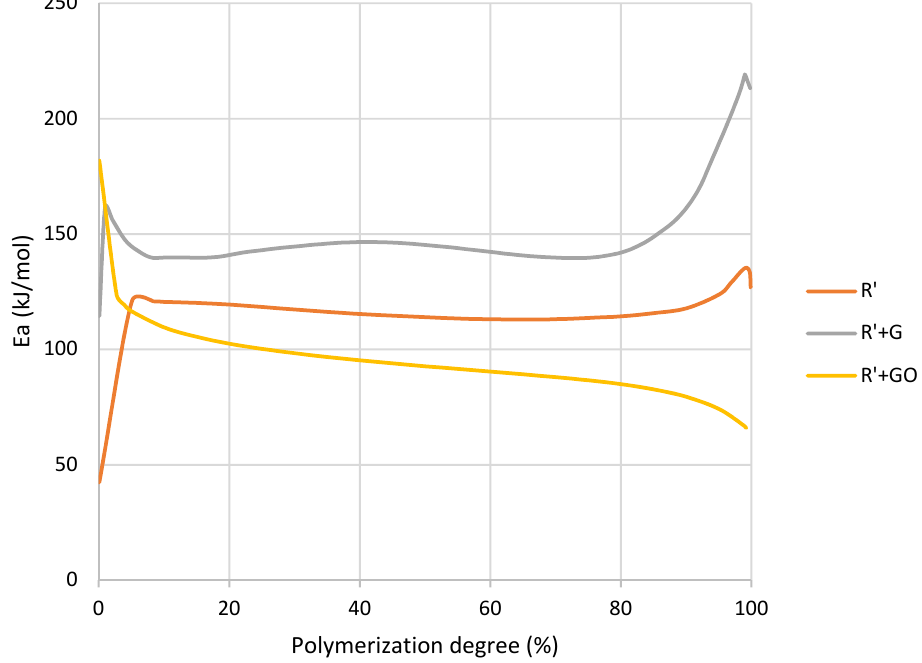
Figure 8. Activation energy as a function of conversion degree of R’ and R’+GBN obtained by MFK model.